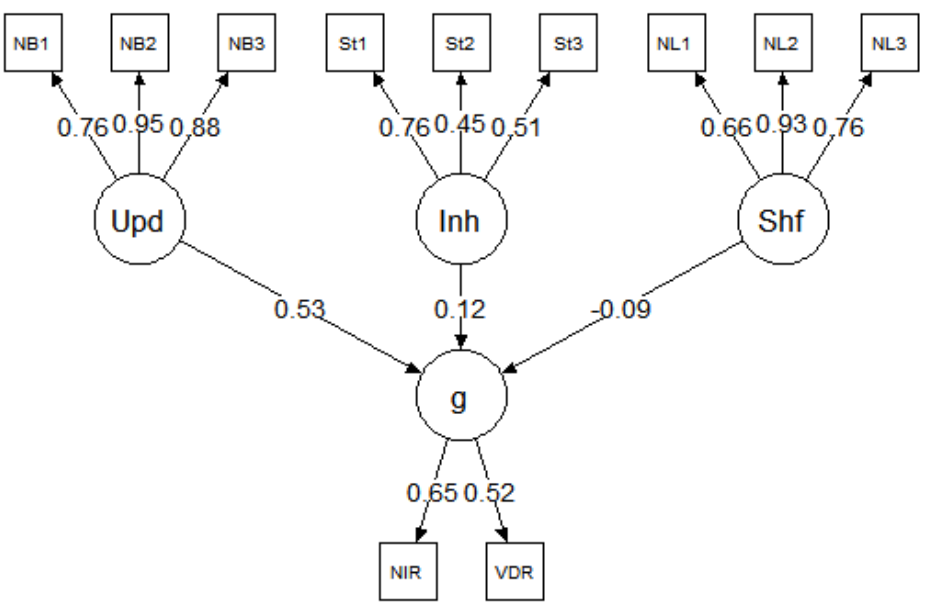
Figure 5. Reanalysis of Benedek et al. (2014). Inh = inhibition; Upd = updating; Shf = shifting; NIR = numerical inductive reasoning; VDR = verbal deductive reasoning.